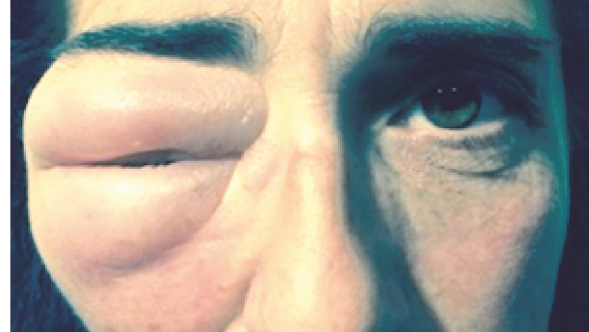
Figure 1: Clinical appearance of the patient with right eyelid